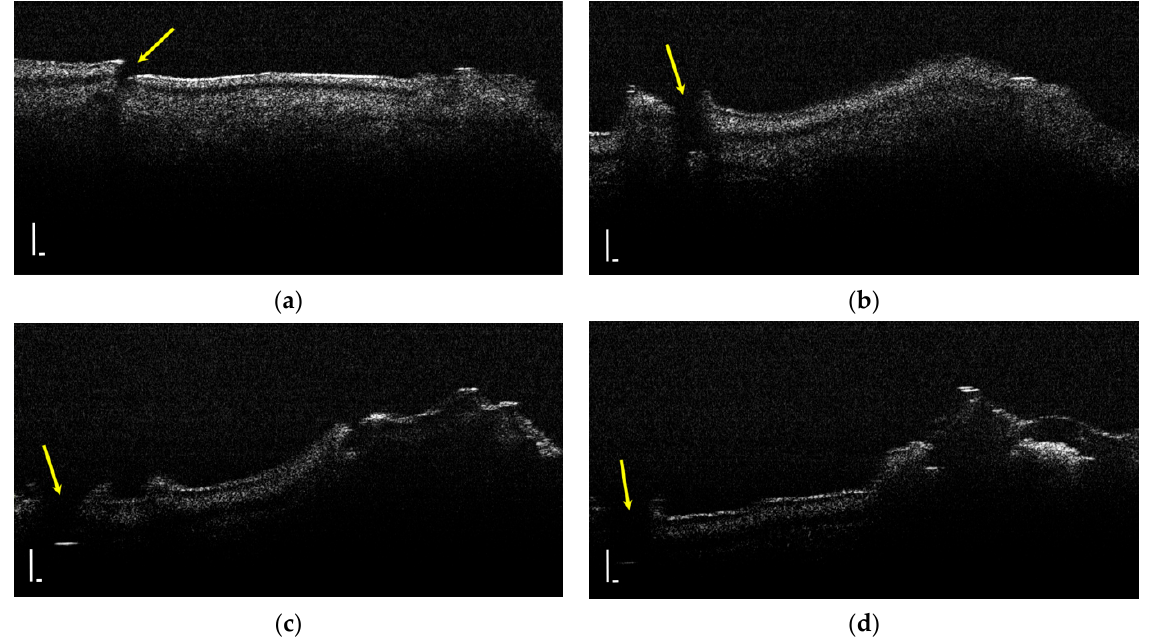
Figure 5. Two-dimensional OCT images of a tooth with hypoplasia (areas marked by yellow arrows): ( a – d ) four frames emphasizing the same hypoplasia lesion, from different perspectives (scale bar 100 μ m).